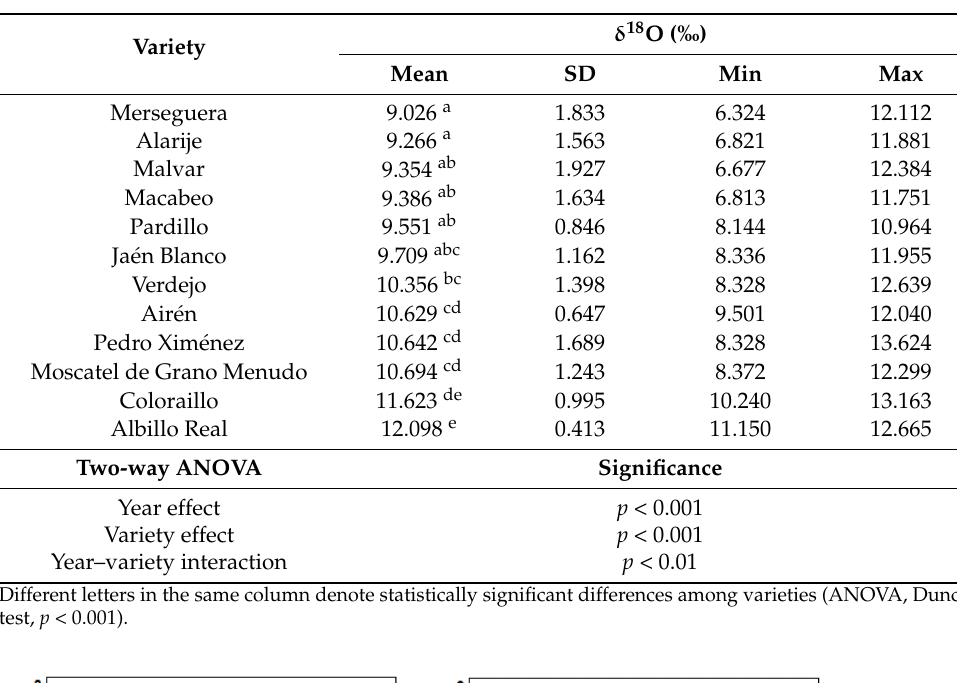
Table 6. Oxygen isotope ratio measured at harvest date in the must water of 12 different white varieties. Values are means, standard deviation, minimum, and maximum values of 15 must samples (five replicates each year).